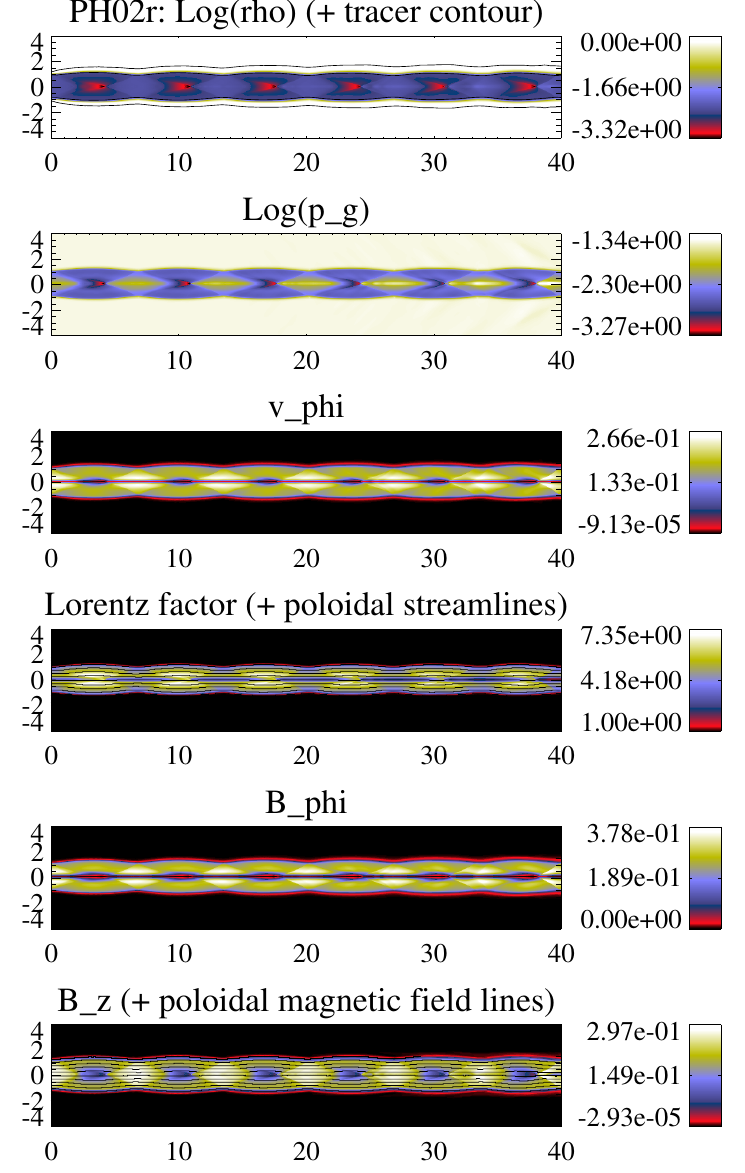
Figure 8. Steady structure of the Poynting-flux-dominated, hot jet PH02 with rotation. Panel distribution as in Figure